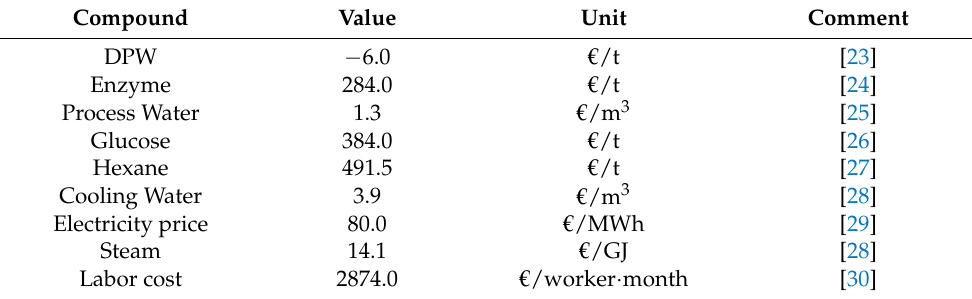
Table 2. Market prices of the raw material, chemicals, utilities, and